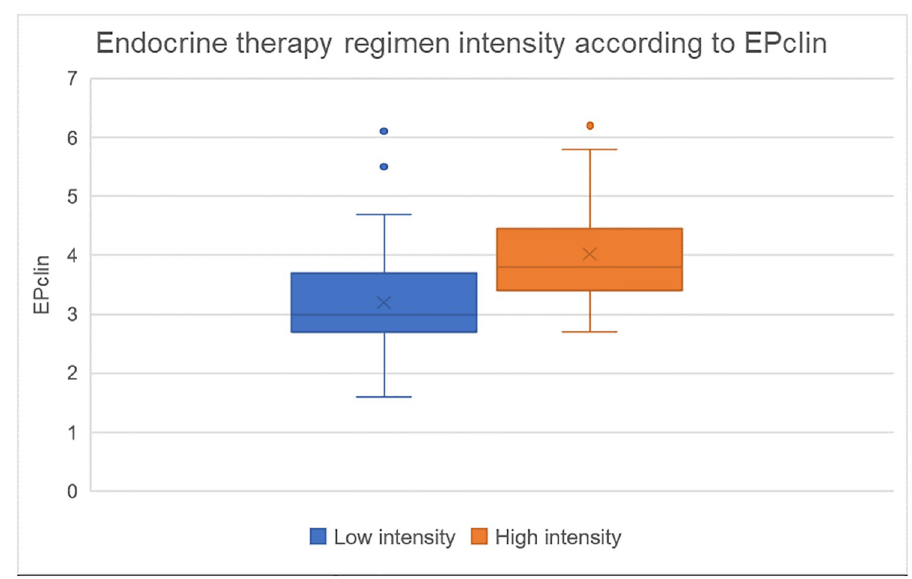
Fig 3. Endocrine therapy regimen intensity according to EPclin.